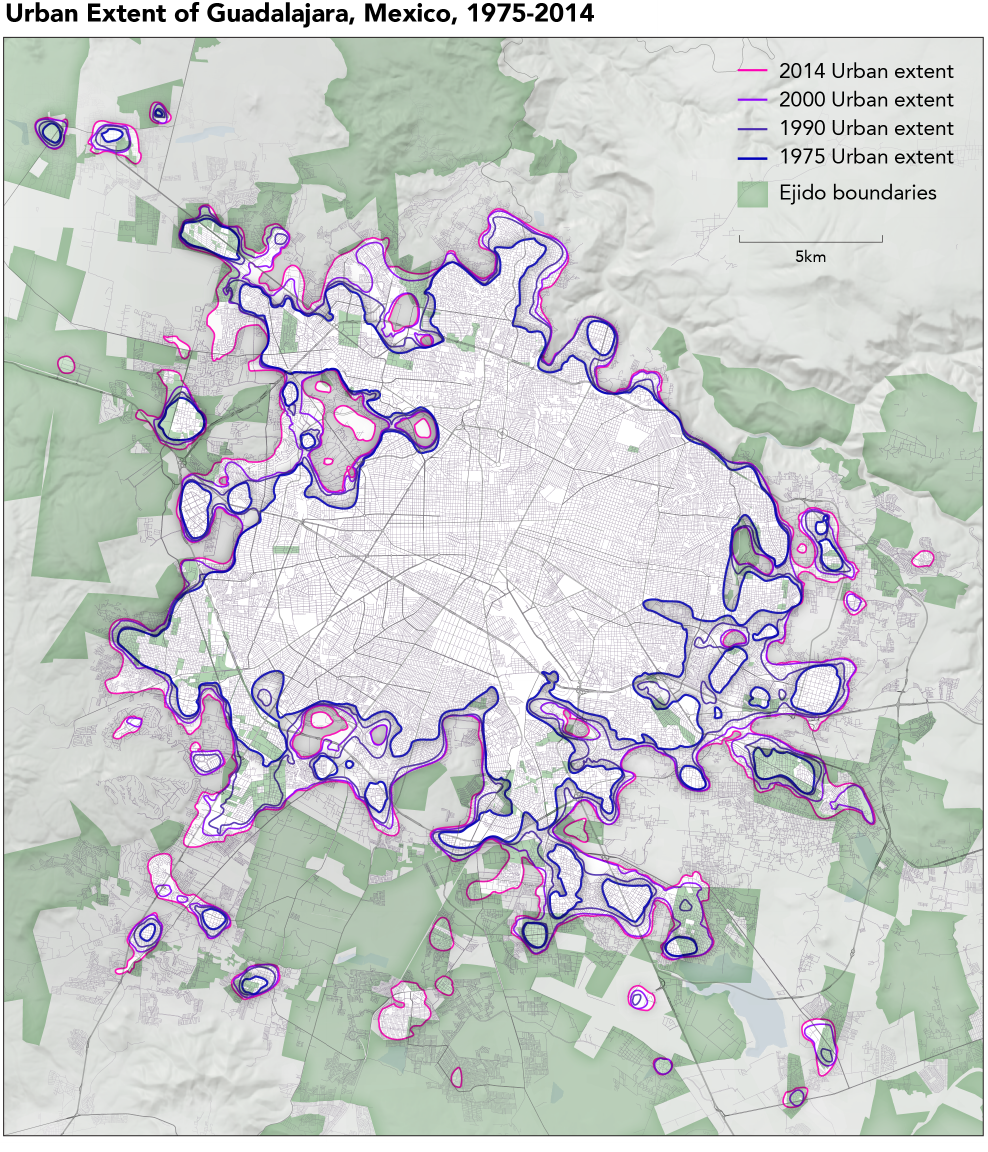
Figure 4. Urban extent over